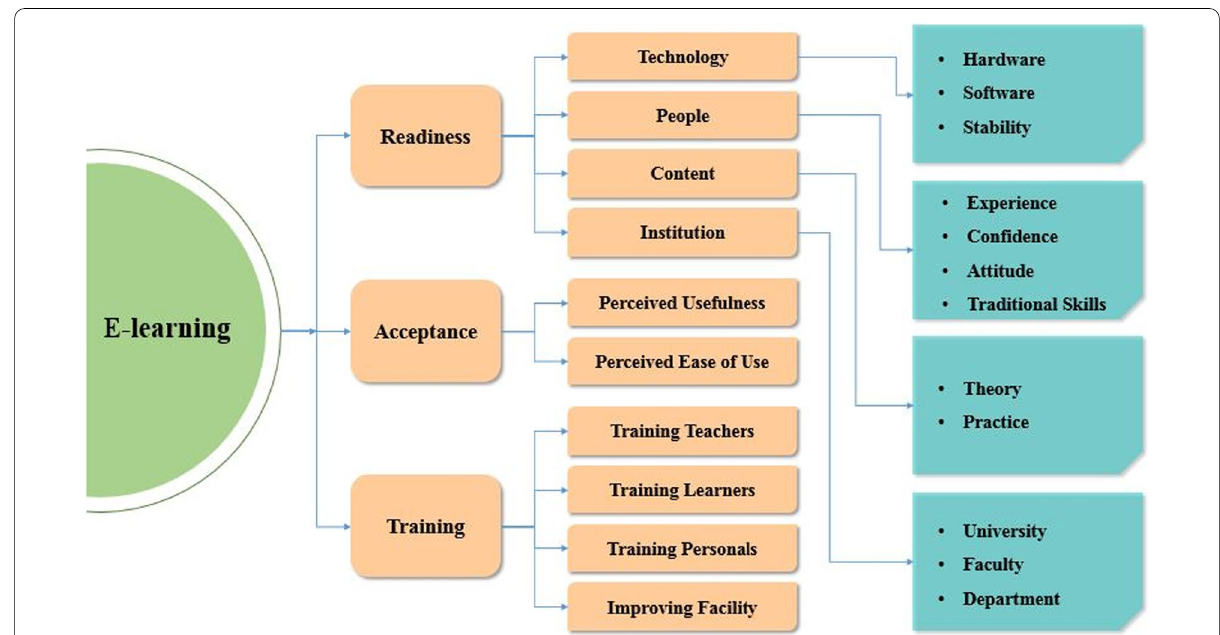
Fig. 2 Model for assessing students’ e-learning